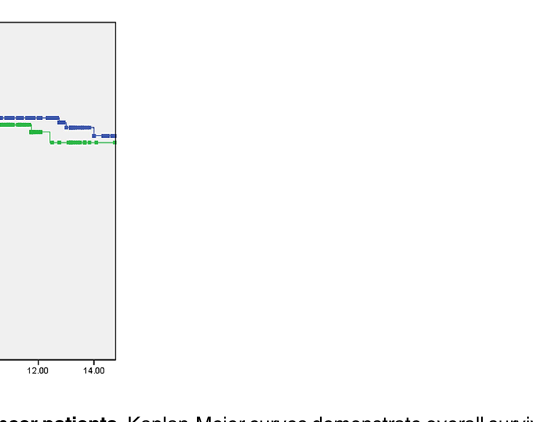
Fig 2. Overall survival in 492 breast cancer patients. Kaplan-Meier curves demonstrate overall survival in 492 study patients. Green line denotes TRAM flap group (n = 213) while blue line represents patients with no reconstruction (n = 279). Abbreviation: TRAM: transverse rectus abdominis myocutaneous.